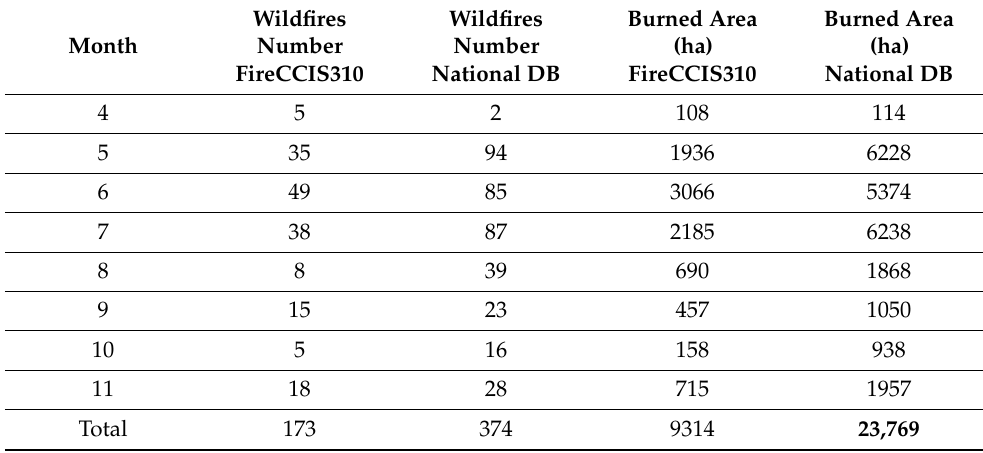
Table A1. The number of wildfires and the sum area burned by month, from the global database (FireCCIS310), and our developed national database.